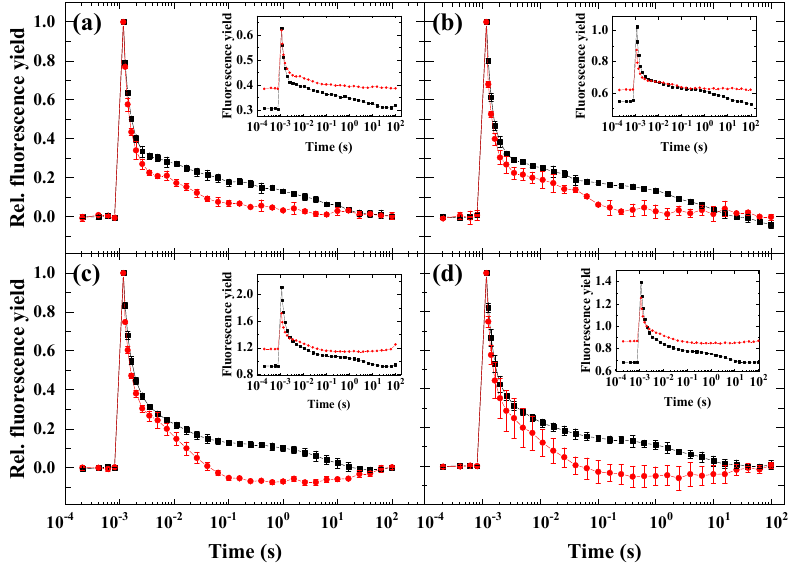
Figure 2. Flash-induced fluorescence relaxation kinetics under aerobic conditions in the absence (black) and in the presence of 1 mM hydroxylamine (red). ( a ) Haematococcus pluvialis (green cells), ( b ) Dunaliella salina , ( c ) Chlorella sorokiniana , ( d ) Nannochloropsis limnetica . Curves were normalized (F 0 to 0 and F m(ST) , which represents maximal fluorescence after the flash to 1) to achieve the same initial amplitudes. The insets show the original curves, averaged over the three biological replicates, without normalization. Error bars represent the standard deviation of the mean of three biological replicates.